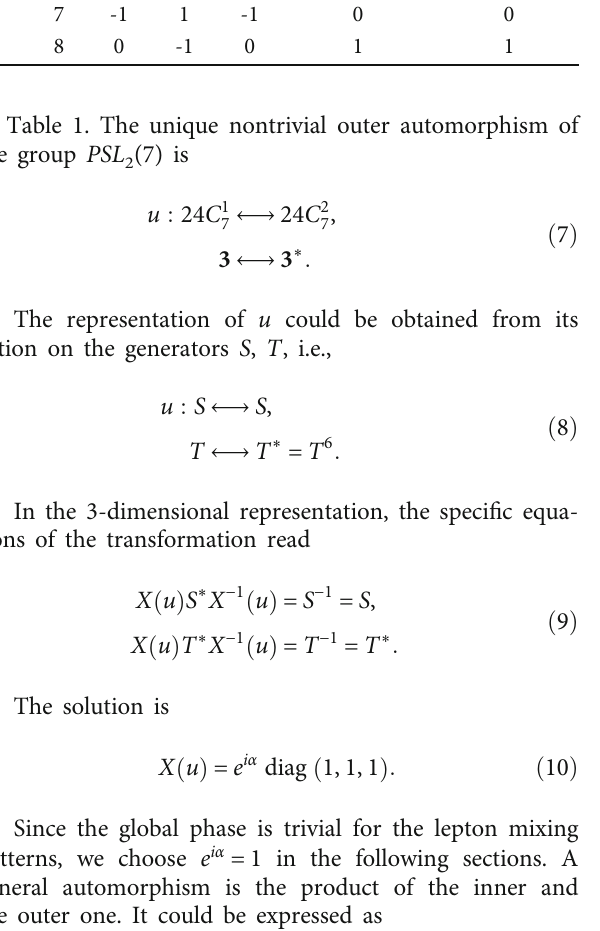
Table 1: Character table of the group PSL